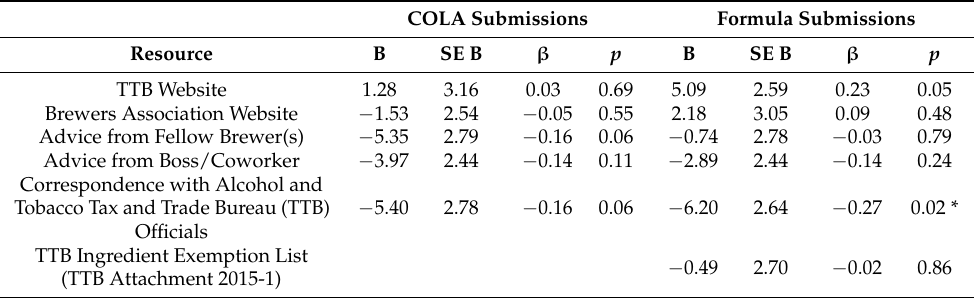
Table 7. Prediction of Resubmission Frequency Using Resource Type.